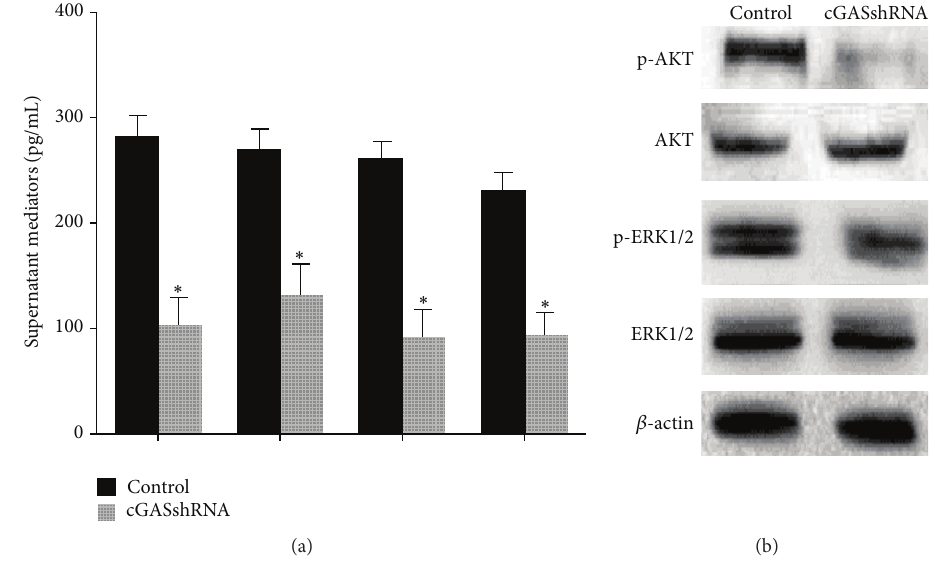
Figure 5: Effect of cGAS silencing on TNF 𝛼 -induced inflammatory responses in RA FLS. (a) FLS infected with cGAS shRNA produced significantly lower amounts of IL-1 𝛽 , IL-6, MMP-1, and MMP-3 than did FLS infected with control ( ∗ 𝑃 < 0.01 ) when exposed to TNF 𝛼 stimulationfor30min.(b)KnockdownofcGASsignificantlyreducedTNF 𝛼 -mediatedERK1/2andAKTphosphorylationbyWesternblotting in the presence of TNF 𝛼 stimulation for 30